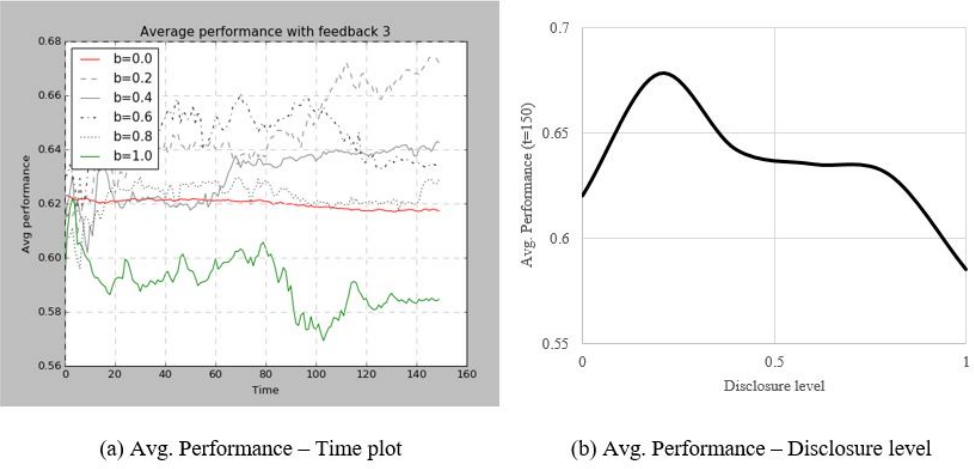
Figure A3. Average performance result of ‘positive feedback to low-performed group’ condition model.